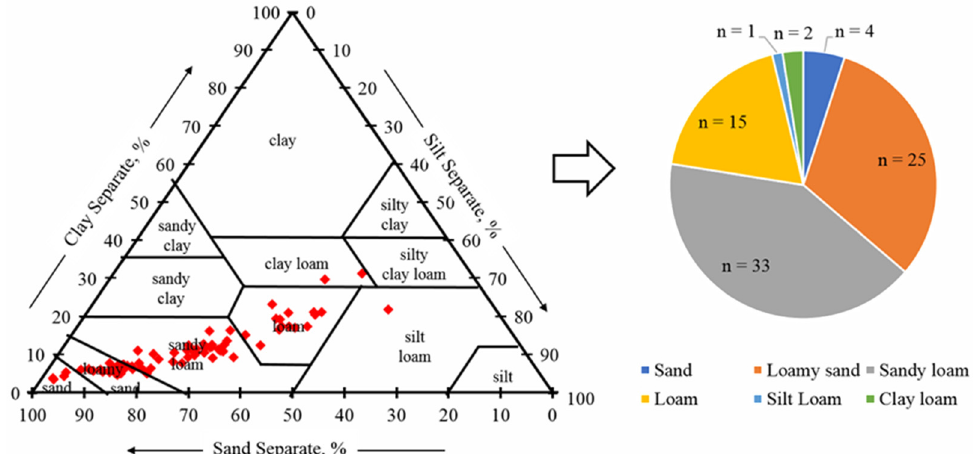
Figure 3. The soil-texture distribution of the study area, according to the international standard for soil classification provided by the International Union of Soil Sciences. The red rhombuses mean the soil samples.